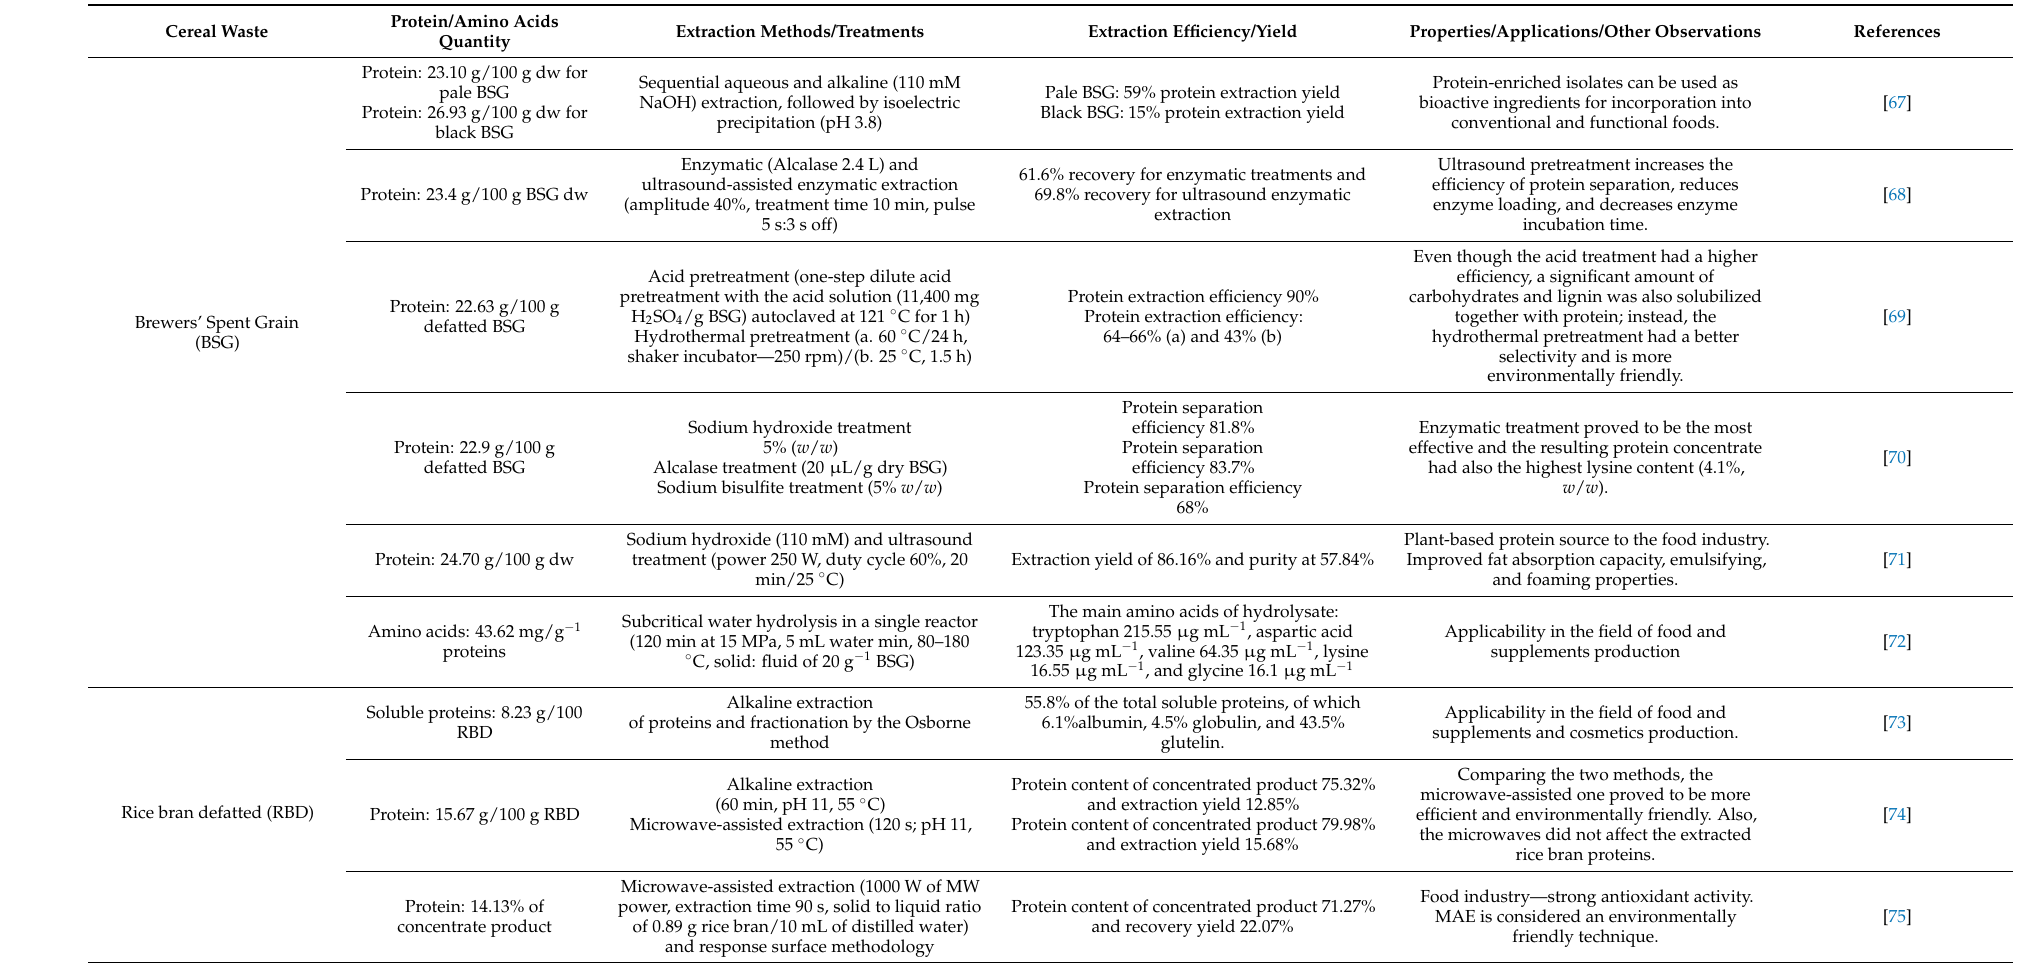
Table 2. Bioactive proteins and amino acids recovered from cereal by-products and